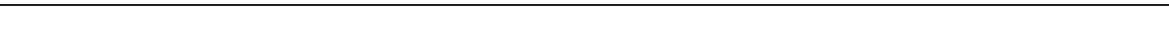
Fig. 2 REGN1908 and REGN1909 simultaneously bind to distinct Fel d 1 epitopes and prevent Fel d 1 binding to Fel d 1-speci fi c IgE. a Non-competitive binding of REGN1908 and REGN1909 was assessed by fi rst injecting nFel d 1 over a CM5 sensor surface immobilized with REGN1908 (left) or REGN1909 (right), followed by the injection of REGN1908 (light blue) or REGN1909 (dark blue). b Using hydrogen/deuterium exchange (HDX), REGN1909 protected a single peptide region in rFel d 1 (dark blue) corresponding to amino acids 32 – 41 of Chain 2. REGN1908 (light blue) protected two peptide regions corresponding to Chain 1 amino acids 43 – 47 and 57 – 71. Light gray lowercase sequence denotes regions not detected by HDX. Violet dots denote residues making contact with REGN1909 Fab as shown in c . c The crystal structure of rFel d 1 bound to the REGN1909 Fab is shown with chain 1 surface colored in white and chain 2 colored in gray. The HDX-protected residues are colored light blue and dark blue as in (b). Atoms making contact (distance <3.5 Å) with the REGN1909 Fab are colored violet. d Representative ELISA using IgE from 1 of 4 donors testing antibody blocking of 0.7 nM rFel d 1.mmh from binding to Fel d 1-speci fi c IgE is shown with mean and SD plotted. e REGN1908, REGN1909, or REGN1908 – 1909 blocking of 200 pM nFel d 1-induced basophil activation from cat-allergic donors, measured by fl ow cytometry and shown as percent maximum inhibition of pErk response relative to isotype control antibody. C and C* represent independent blood donations from the same donor 2 months apart. Individual donor and antibody dose – response data are shown in Supplementary Fig. 2. f REGN1908 – 1909 blocking of 20 pM nFel d 1-induced basophil upregulation of CD203c hi (left) or CD63 hi (right) was measured by fl ow cytometry. Average value of duplicate wells and SD are shown. One representative donor out of 8 tested and 1 of 4 are shown for CD203c and CD63 activation, respectively. For combination studies REGN1908 – 1909 are combined in a 1:1 molar ratio and total antibody is plotted. Flow cytometry gating strategies are shown in Supplementary Fig.